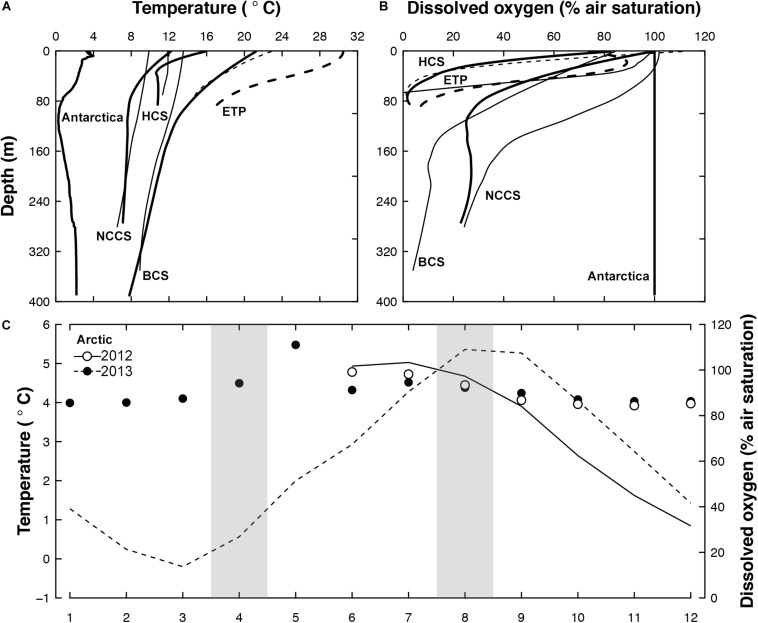
Temperature and oxygen during sampling periods. Depth profiles of (A) mean water temperature and (B) dissolved oxygen in Antarctica, the Humboldt current system [HCS], the Eastern Tropical Pacific [ETP], the Benguela Current System [BCS], and the Northern California Current System [NCCS]. Bold lines represent summer conditions and dashed lines the ETP area. (C) Monthly mean temperature (line) and dissolved oxygen (dots) in the Arctic with sampling periods shaded in gray. Data were compiled from the AWIPEV underwater observatory located at 12 m water depth (Fischer et al., 2018a, b).